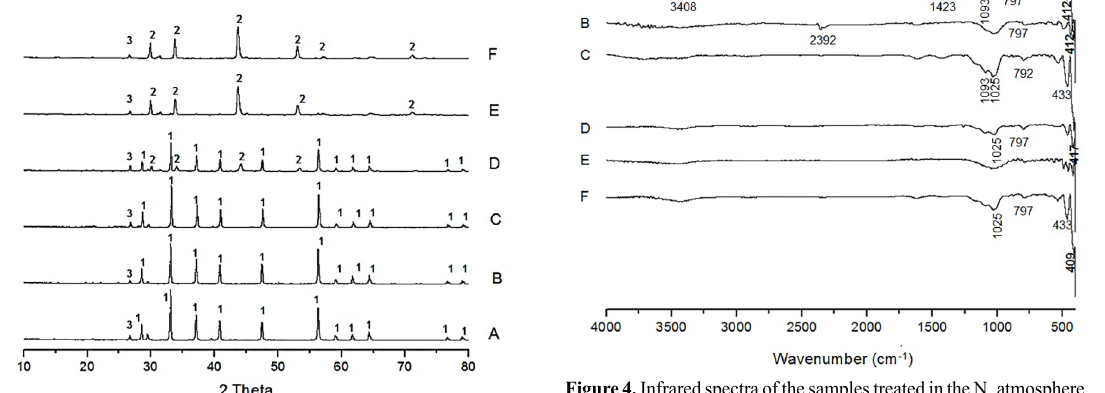
Figure 4. Infrared spectra of the samples treated in the N atmosphere: 1) 2